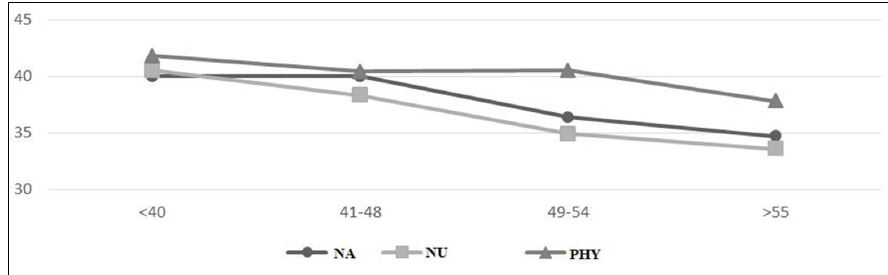
Figure 1. Age distribution of workability. NA, nursing aides; NU, nurses; PHY, physicians.